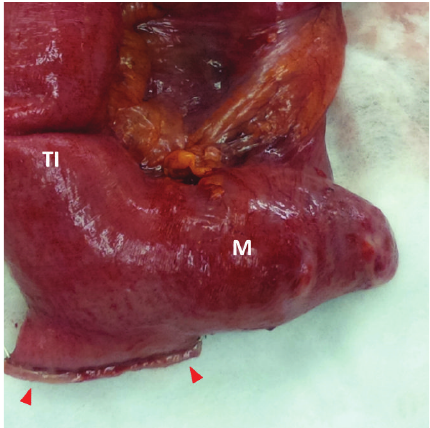
Figure 1: Coronal section from computer tomography imaging demonstrating the point of colonic volvulus (red arrows) within the transverse colon (T).